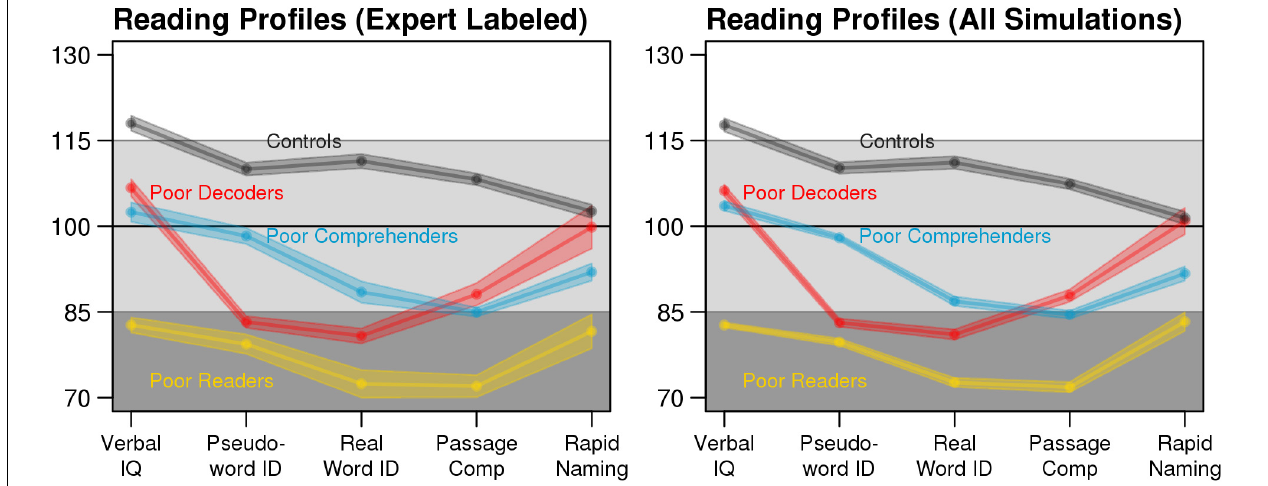
FIGURE 1 | Consistent expert-labeled (left: n = 198) and synthetic data reading profiles (right: n = 500). Each point connected by a solid line is the mean test score and the shaded area depicts the standard error of the mean (SEM). For the synthetic data profiles, average test scores and SEM were calculated for each dataset with no missing data, then averaged across the 1,000